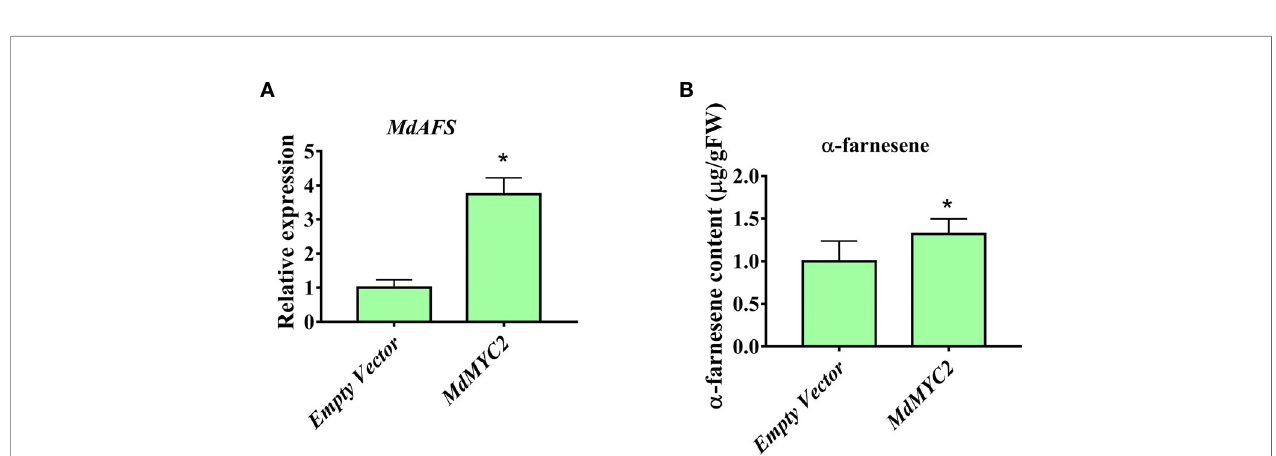
FIGURE 5 | Transient expression of MdMYC2 in apple peel. (A) Relative MdAFS gene expression in apple peel injected with Empty Vector and MdMYC2 . (B) a -farnesene content in peel in fi ltrated with MdMYC2 . More than three apples were injected for determination, and the data were the average value obtained. * indicates P < 0.05 compared to Empty